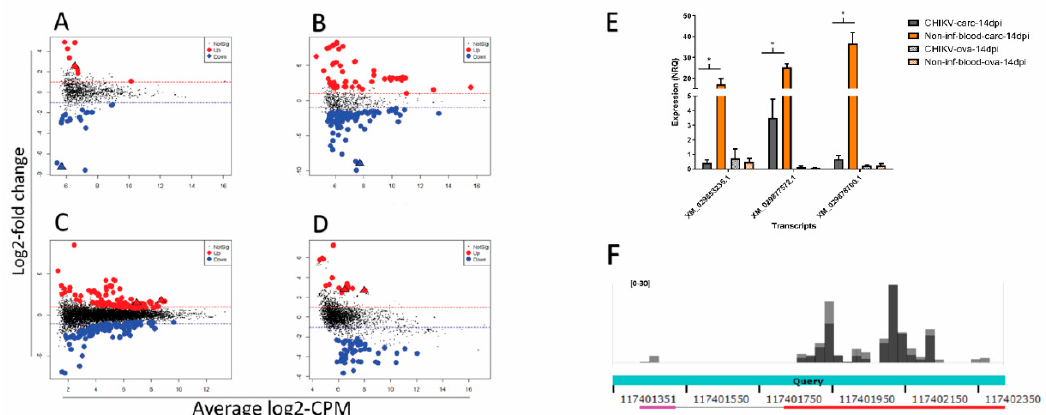
Figure 4. Differential abundance of small RNA molecules mapping to Ae. albopictus transcripts represented by average log counts-per-million (CPM) on the x-axis and log fold-change on the y- axis. Red dots indicate significantly over-expressed sRNAs and blue dots significantly under-expressed sRNAs upon infection compared to un-infected controls. Statistical significance of the data was assessed by likelihood ratio test. ( A ) siRNA abundance of transcripts in CHIKV-infected ovaries; ( B ) siRNA abundance of transcripts in CHIKV-infected carcasses; ( C ) piRNA abundance of transcripts in CHIKV-infected ovaries; ( D ) piRNA abundance of transcripts in CHIKV-infected carcasses. Triangles indicate transcripts tested by qPCR. ( E ) Bar plot of the qPCR results on transcripts to which SDA small RNAs are mapped to. Significant results at p < 0.05 are indicated by an asterisk. Significance was established by ANOVA. ( F ) Normalized coverage of the Ae. albopictus genomic region NW_021838576.1:117401889-117402177. The two shades of grey represent the biological replicates. Query bar indicates alignment similarity to XM_029878700.1 as computed by BLASTn online.